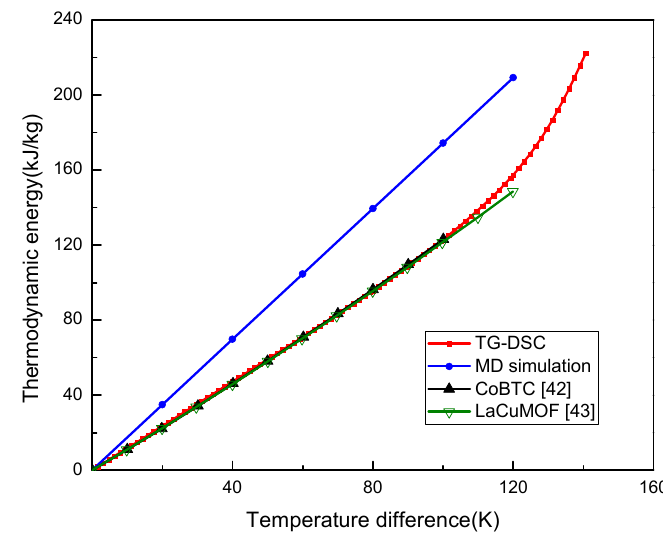
Figure 2. Thermodynamic energy of UIO-66 measured by MD and TG-DSC.